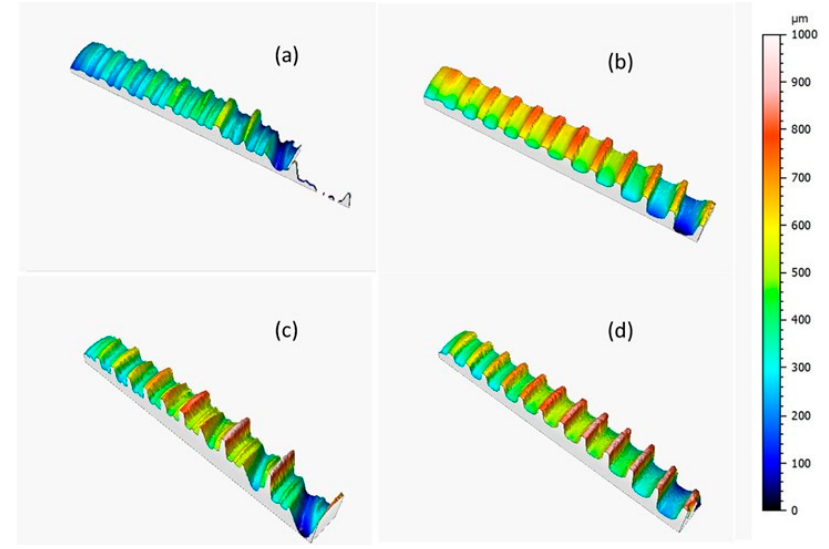
Figure 2. Topographies of the dental implants acquired with a Leica DCM3D microscope with